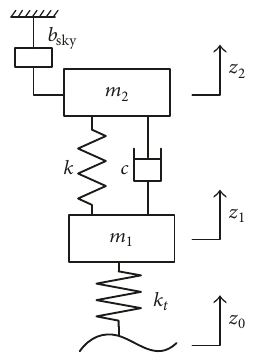
Figure 1: A virtual Skyhook inerter